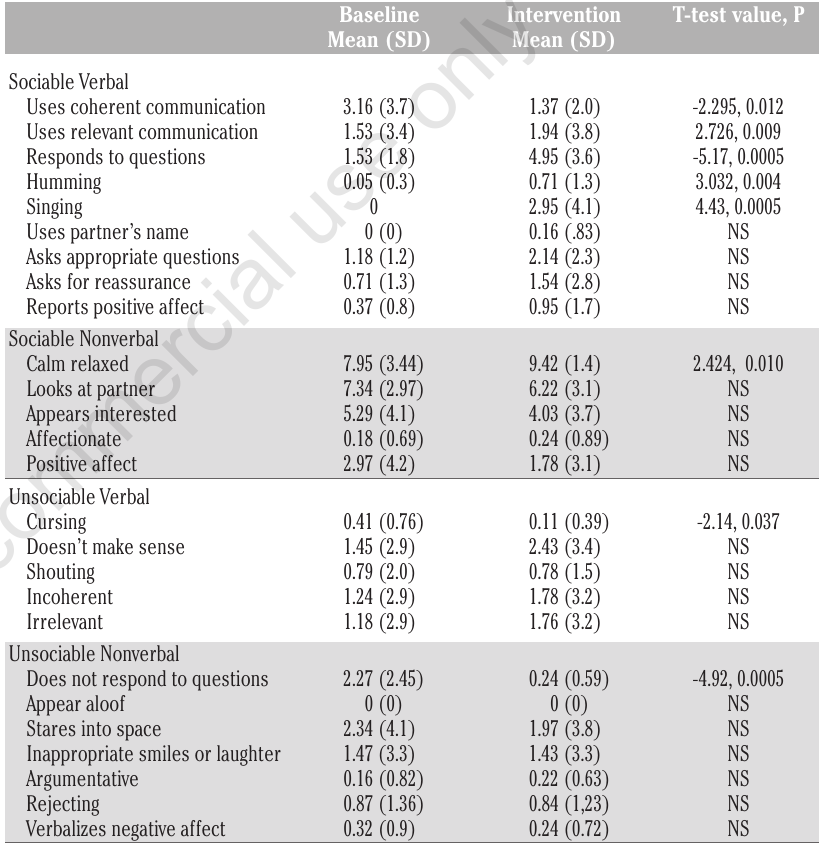
Table 1. Comparisons of verbal and nonverbal observations at baseline and during music therapeutic care intervention. Baseline